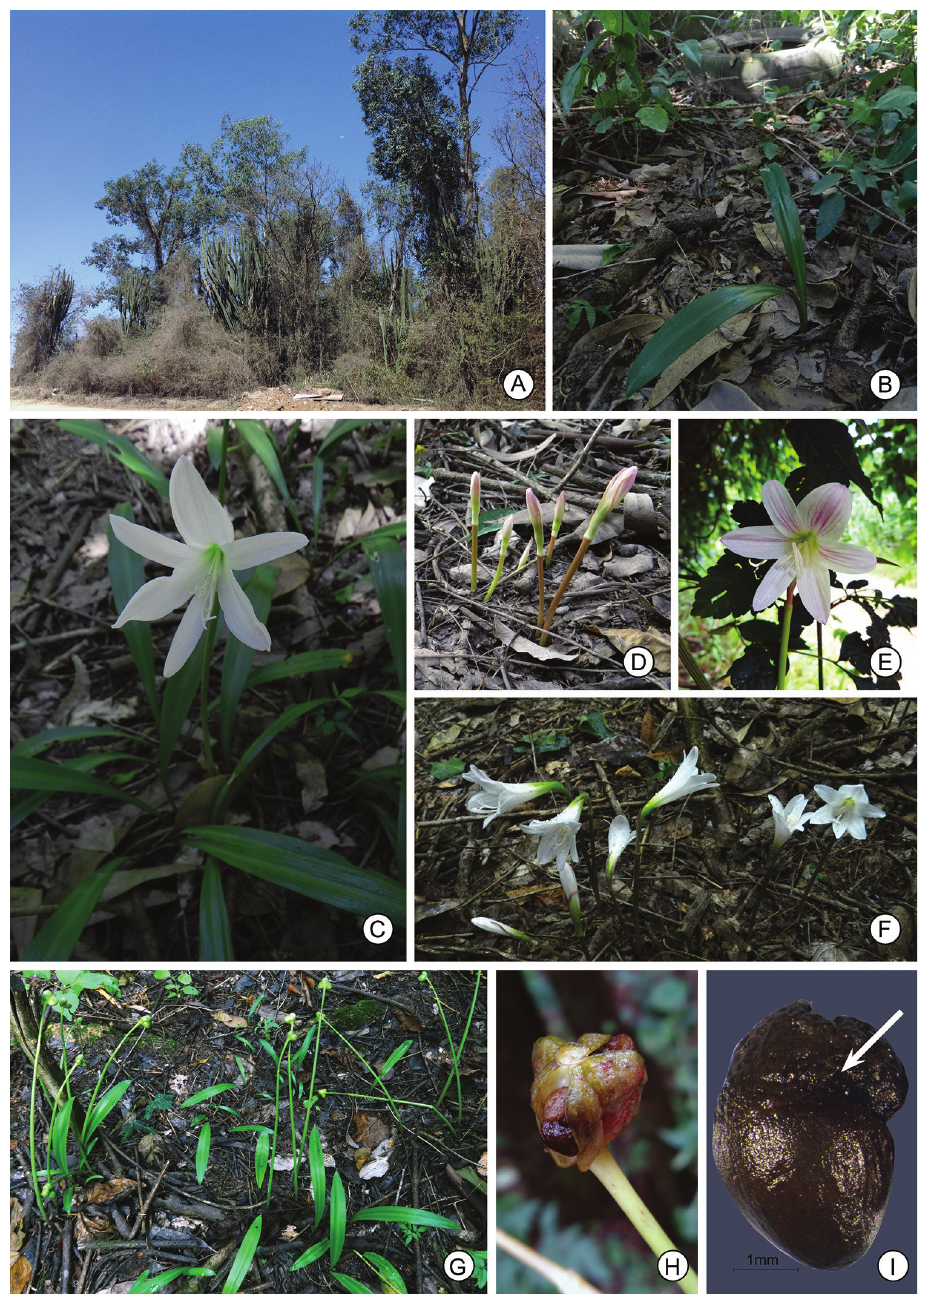
Figure 2. Eithea lagopaivae A Typical habitat (October 2016) B Individual plant flowering amid trash dumped at type locality C Flowering plant ( Campos-Rocha 1647 ) D Flower buds E Flower, frontal view ( Bernacci 4483 ) F Flower buds and flowers ( Campos-Rocha 1654 ) G Plants in fruit H Mature capsule exposing the seeds I Seed (elaiosome indicated by the